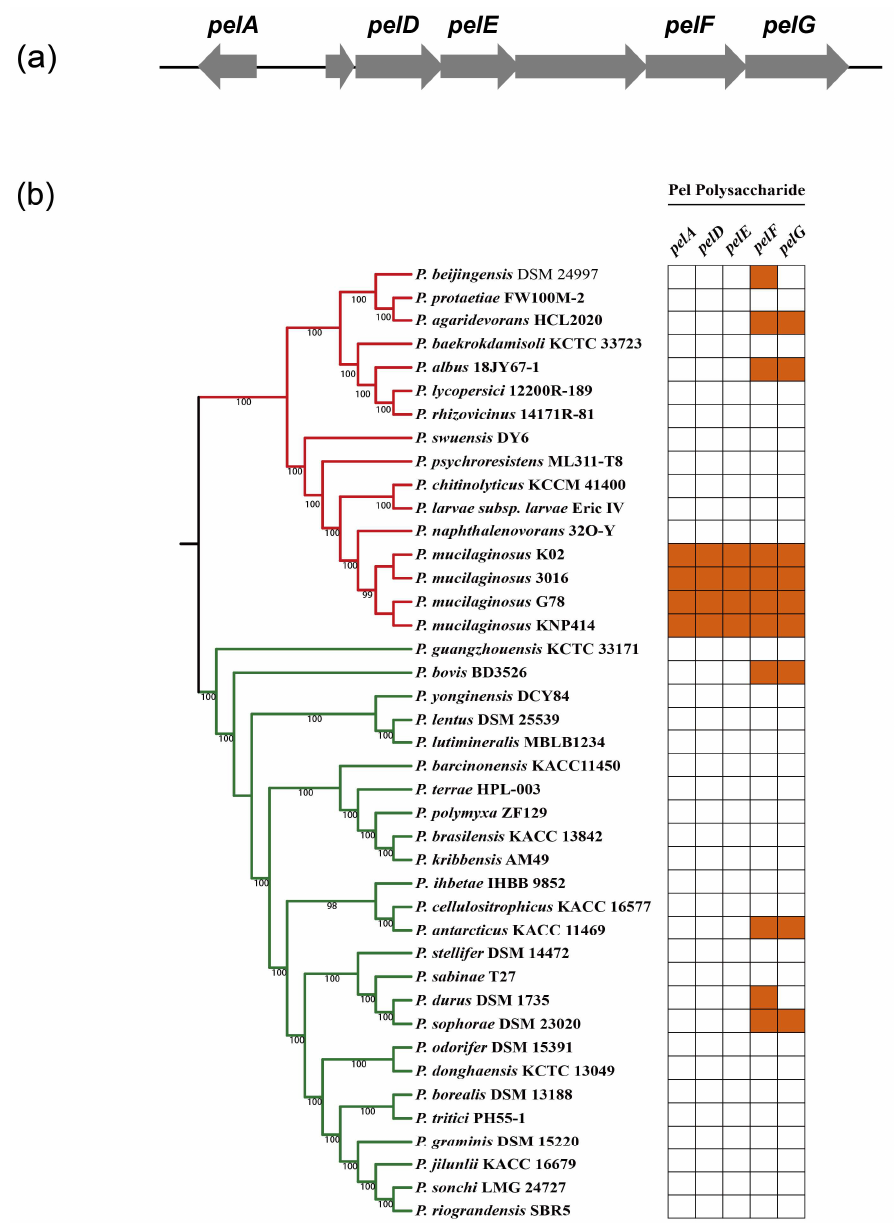
Figure 4. pel -like operon of P. mucilaginosus G78 and genes involved in Pel-polysaccharide of 41 Paenibacillus strains. ( a ) pel -like operon architectures of P. mucilaginosus G78. Arrows are used to denote open reading frames, with the direction of each arrow indicating the direction of transcription. ( b ) pelAEDFG genes of 41 Paenibacillus strains. Colored box represents the presence of a gene within a genome and white box indicates absence of a gene.